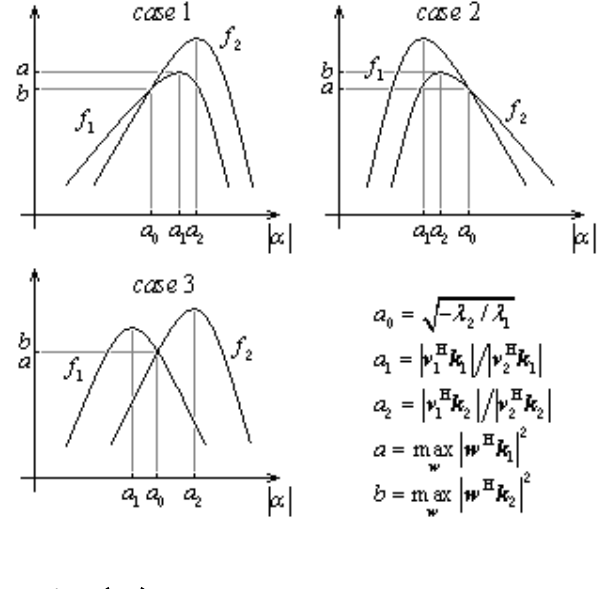
Figure A1. The sketch map of the three sub-cases of the model solution in the second